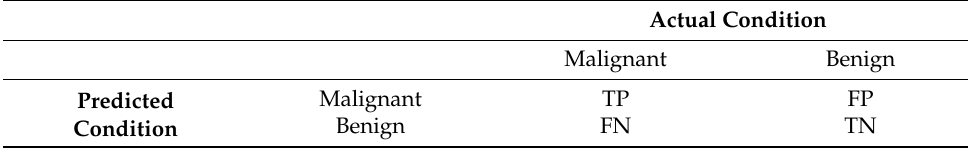
Table 1. Confusion matrix conditions for metrics